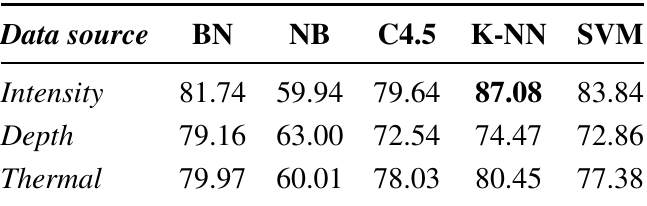
Table 6. Best 10-fold cross-validation accuracy percentage obtained for each classifier using the EUREKA! original images.